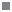
Comparison of CNAs in the same set of biomarkers in matched frozen and FFPE tissue specimens measured by our multiplexed ddPCR method.Mean normalized Ri/b values were determined for 15 biomarkers in DNA extracted either frozen or FFPE tissue biopsies of SCC in Area 1 (■) or the dysplasia in Area 2 (○). In general good agreement of normalized Ri/b values is observed between the matched samples when the fragmentation correction is applied (A), while a much poorer agreement is observed when the fragmentation correction is not applied (B). Error bars represent a 95% confidence interval.